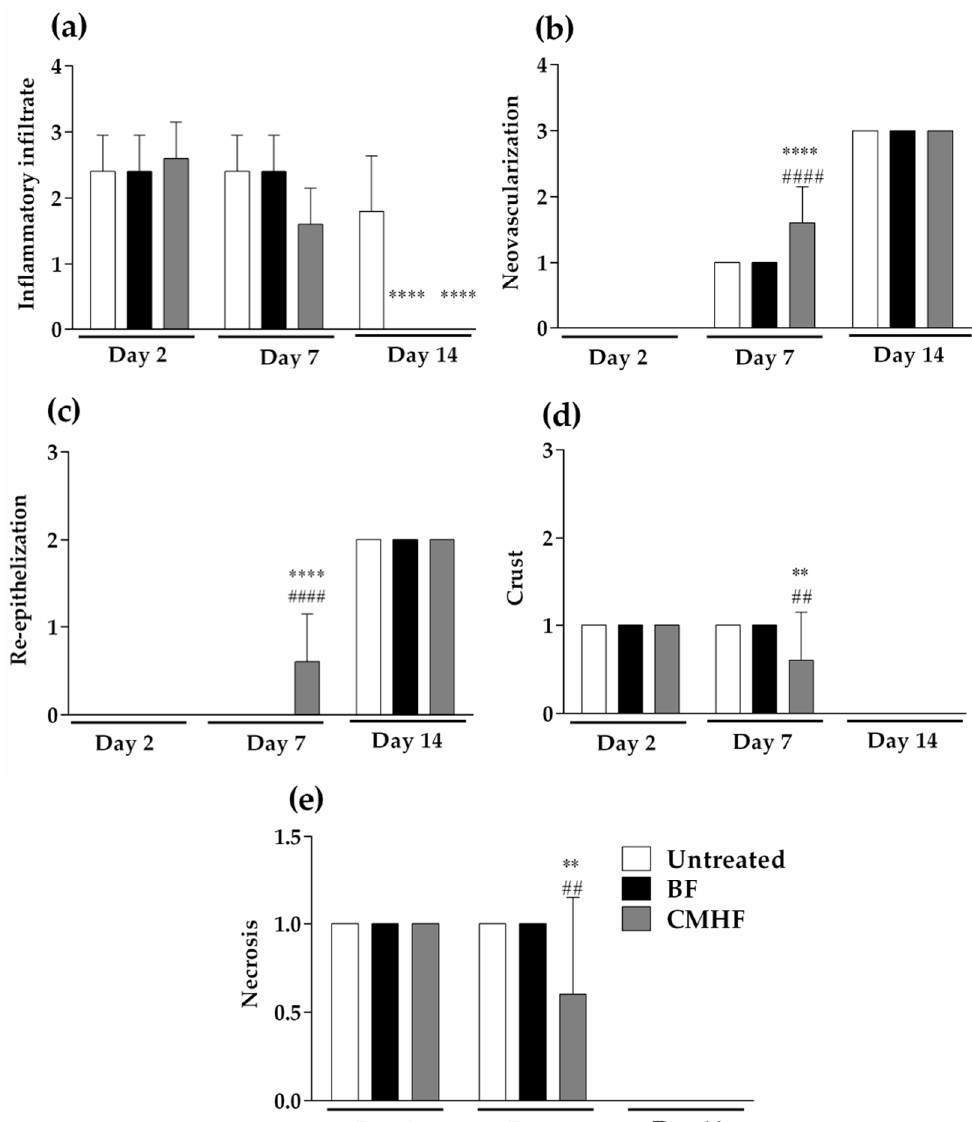
Figure 9. Hystomorphology of H&E-stained epithelial tissue from the untreated, BF, and CMHF groups. ( a ) Inflammatory infiltrate; ( b ) neovascularization; ( c ) re-epithelization; ( d ) crust; ( e ) necrosis. Statistical difference demonstrated by ANOVA analysis followed by Tukey post-test. Data represents the mean of the values obtained from five animals and the vertical lines indicate the standard deviation. **** p < 0.0001, and ** p < 0.01 for comparison between the untreated and BF groups; #### p < 0.001, and ## p < 0.01 for comparison between the BF and CMHF groups.